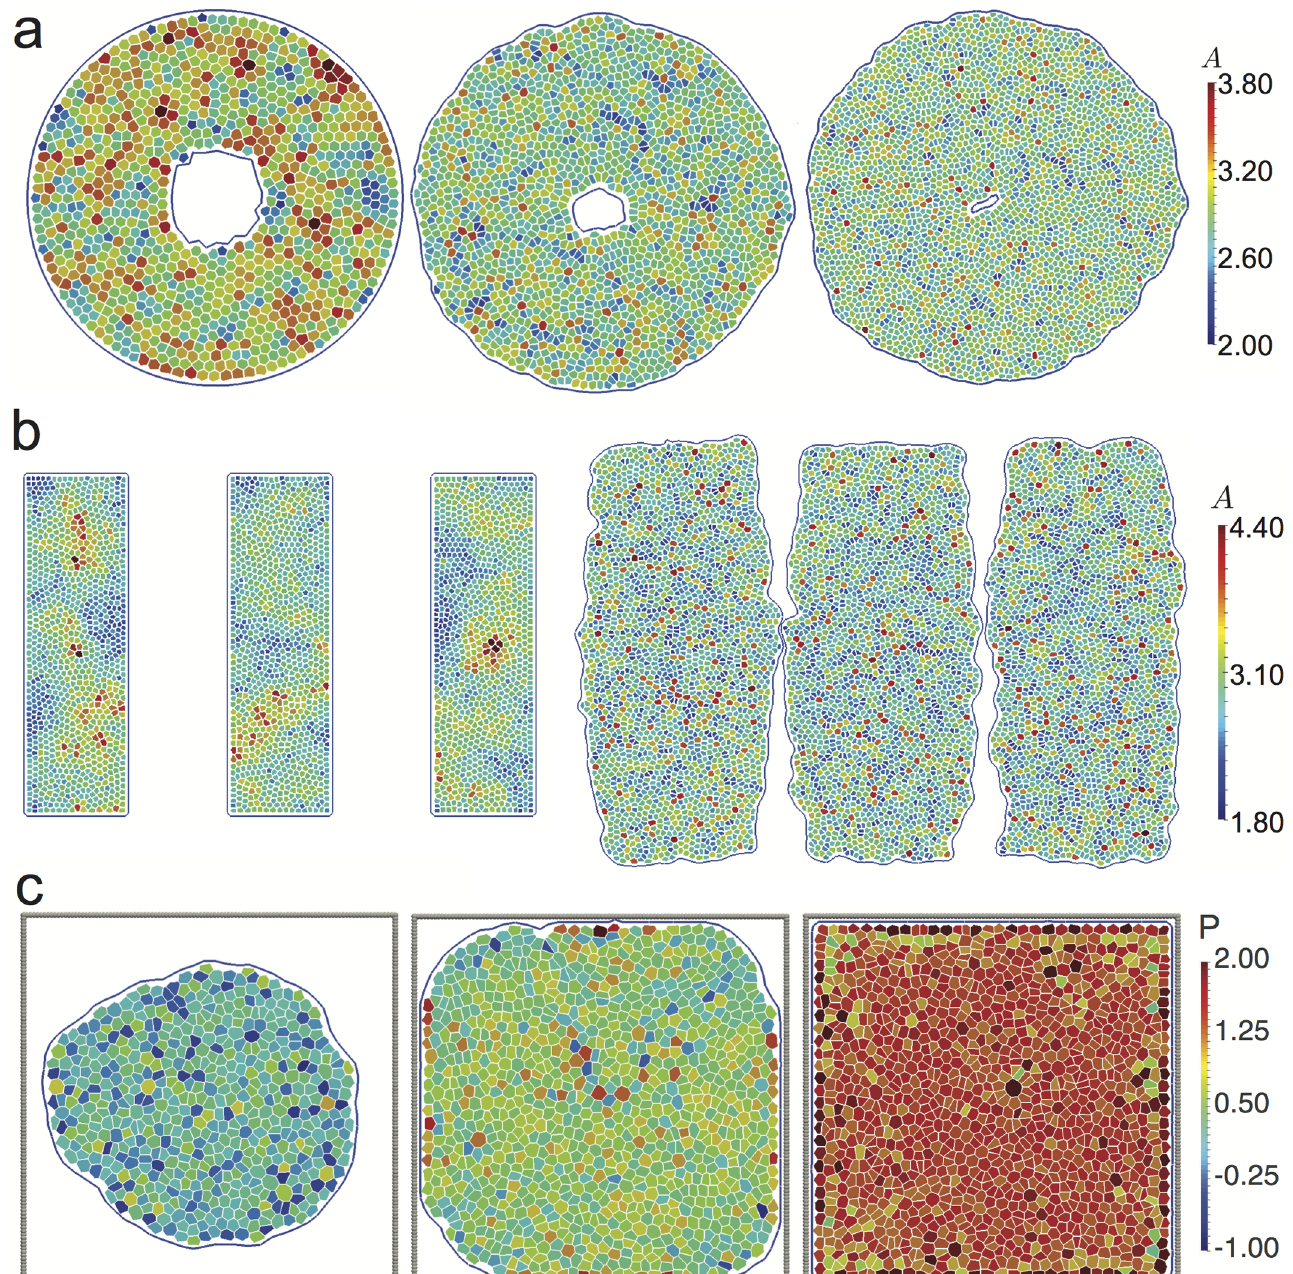
Fig 11. (a) Snapshots of the simulationof a cell sheet with an annulargeometry used to illustrate how cells divide and fill the circular void in the centre. The system configuration was recordedat times 0, 1000 and 1700. The initial configurationhas p 0 = 3.46, i.e., it was in the solid-likephase. While it is not simple to define p 0 for a growingsystem due to a constant changein the cell target area A 0 , we note that throughoutthe simulation, cell shapes remain regular. (b) Illustration of a common experimental setup where cells are grown in rectangular “moulds” for a system with initial p 0 = 3.35. Once the entire regionis filled with cells, the mould is removedand the colony is allowedto freely grow. Images on the right show two of the strips about to merge. In (c), we model tissue growth in confinement using a system with initial p 0 = 3.46. Grey beadsform the boundary of the confinement regionthat constrainthe cell growth. Initially, cells do not touch the wall and freely grow. As the colony reachesthe wall, one starts to notice pressure buildup. Finally, the entire cavity is filled with cells and any subsequent divisionleads to increaseof the pressurein the system. Snapshots were recordedat times 1200, 1480and